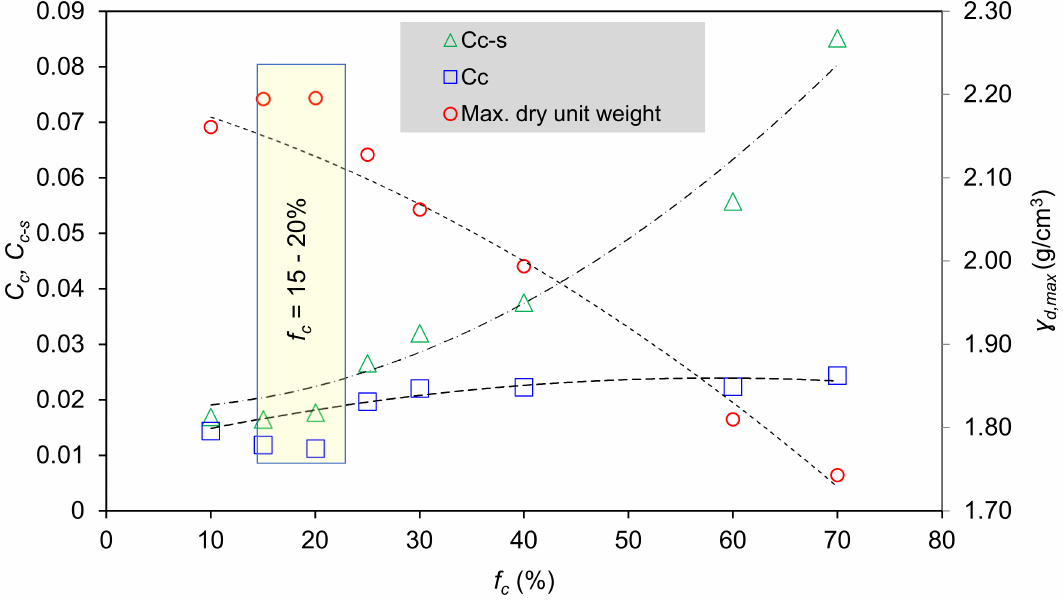
Figure 9. Relationship between the granular compression index and maximum dry unit weight.